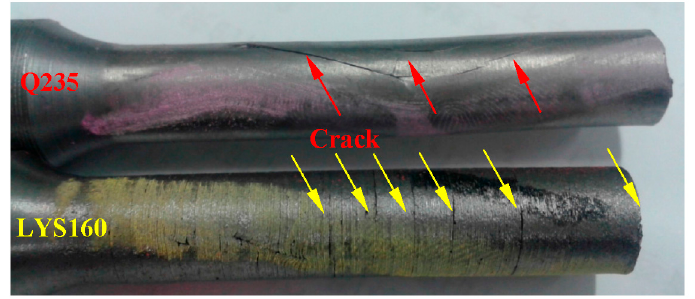
Figure 11. Comparison of the failure mechanism in Q235 and LYS160.